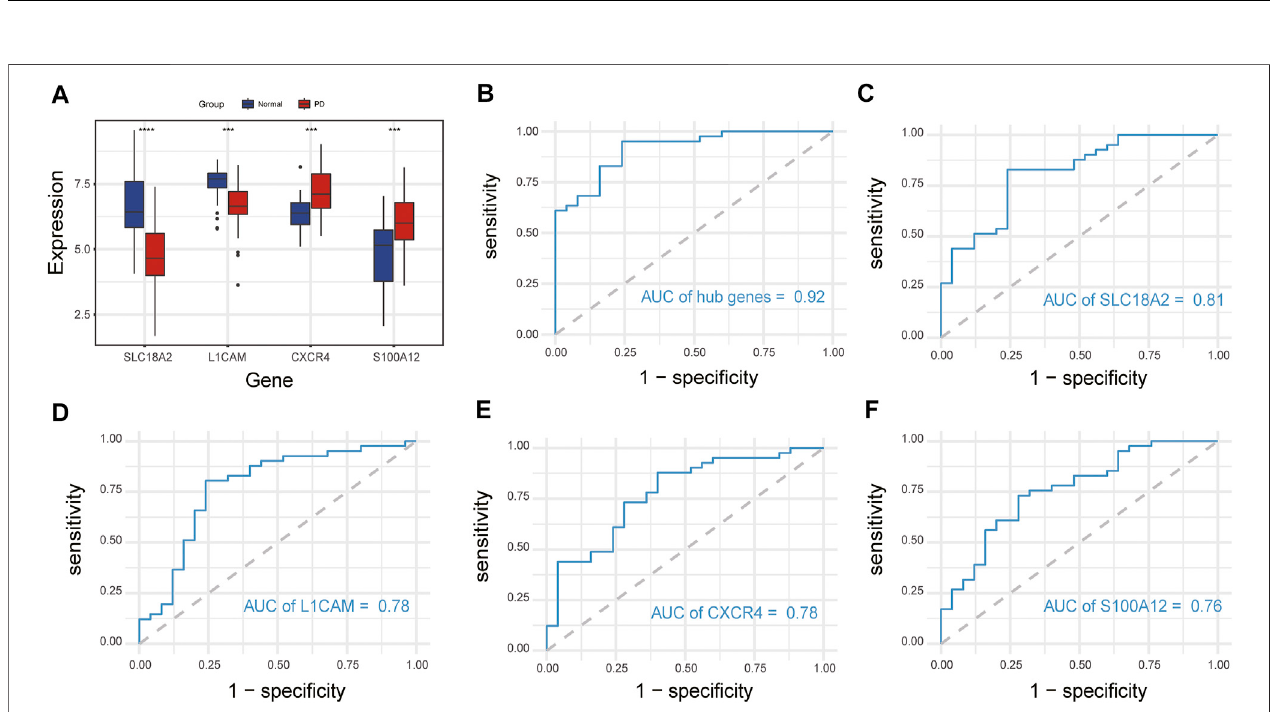
FIGURE 7 | Expression of immune-related hub genes and ROC curve of immune-related hub genes. (A) Expression of hub genes in 41 PD and 25 healthy control samples. (B) TheROCcurveoffourimmune-relatedhubgenes. (C – F) TheROCcurveofeachimmune-relatedhubgene.ns, p > 0.05,* p < 0.05,** p < 0.01,*** p < 0.001, **** p <